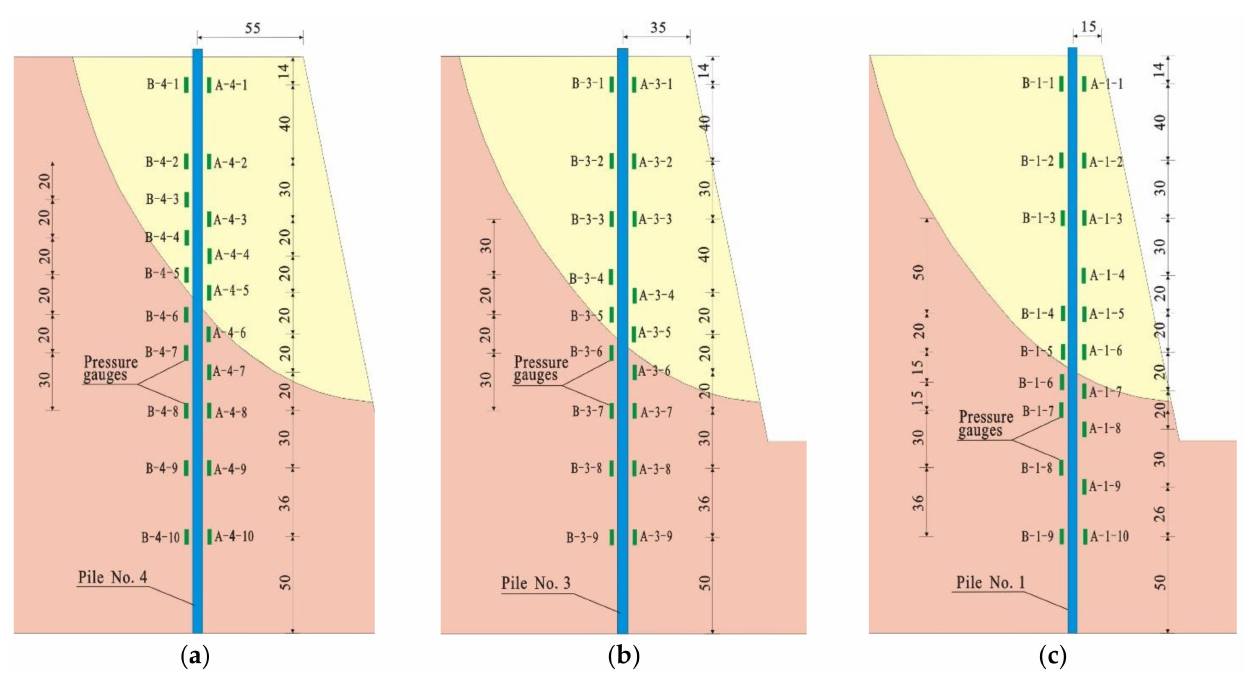
Figure 5. Distribution of the pressure gauges in a vertical direction along the pile: ( a ) the position and number of pressure gauges along the pile no. 4 (unit: cm); ( b ) the position and number of pressure gauges along the pile no. 3 (unit: cm); ( c ) the position and number of pressure gauges along the pile no. 1 (unit: cm).